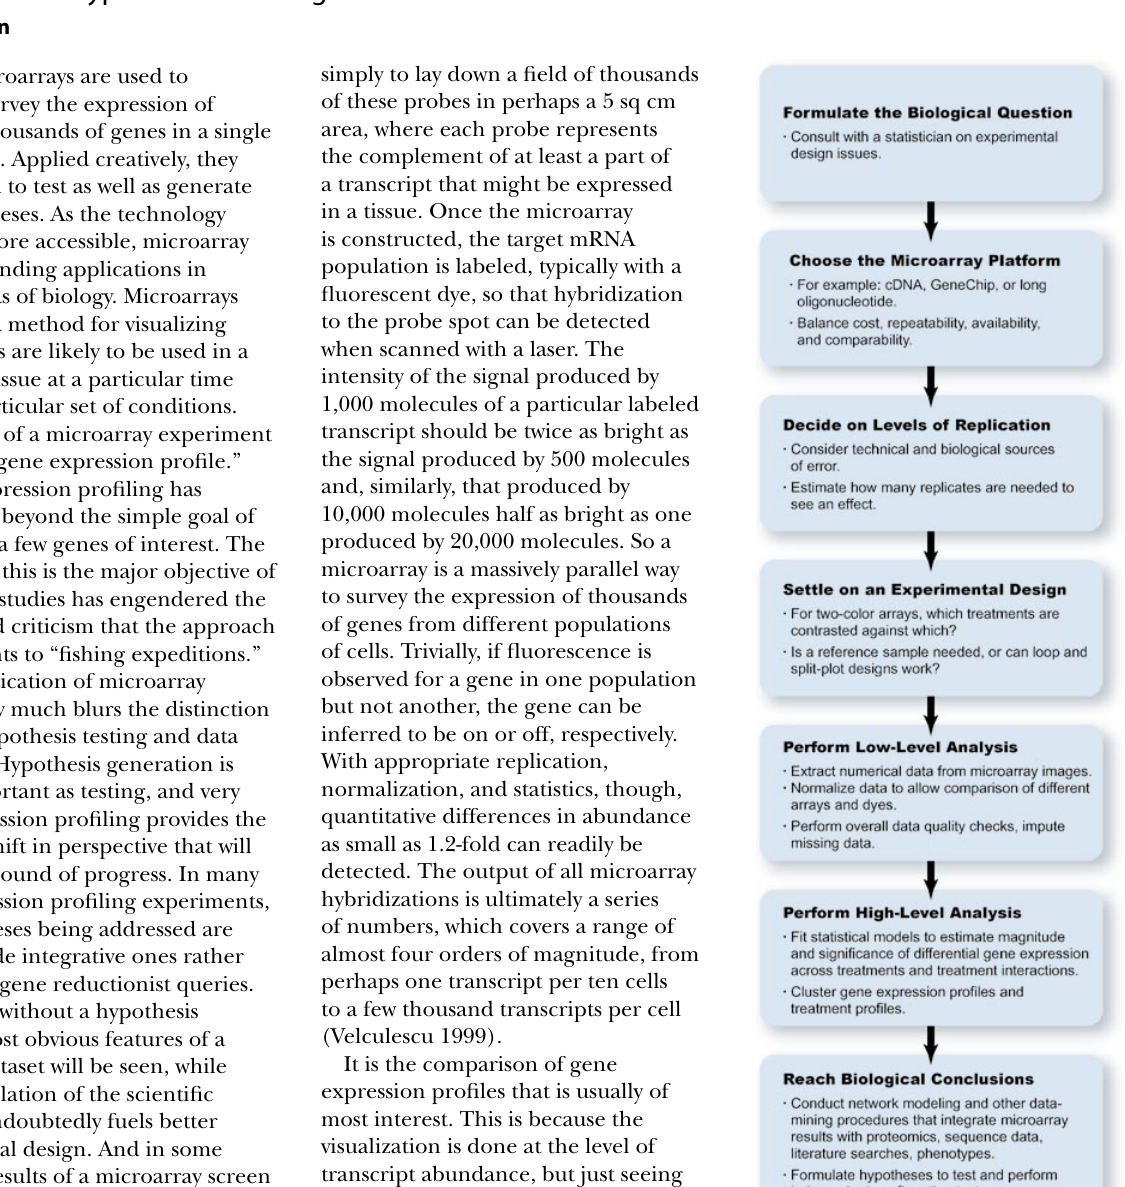
Figure 1. Having performed the experiment, quality control checks, statistical analysis, and data-mining are performed. More and more,